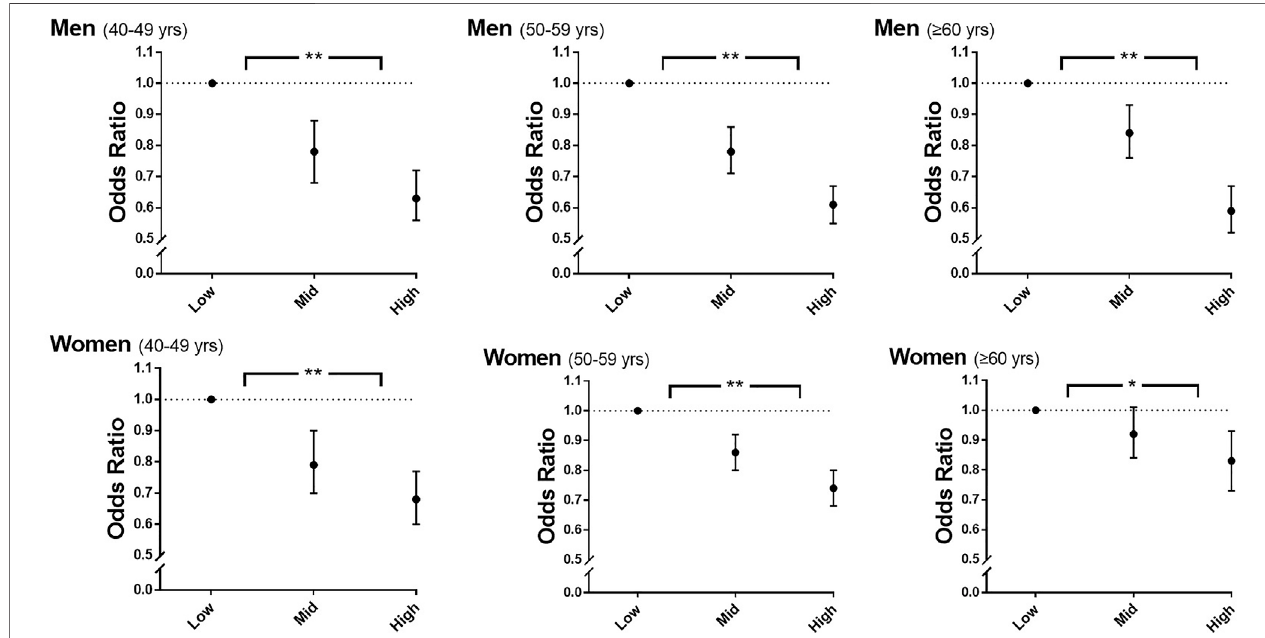
FIGURE2 | Odds ratios for hypertension according tosex-speci fi c tertiles ofrHGS and age. Adjusted for age, drinking, smoking, education level,total cholesterol, diabetes mellitus, visceral adiposity index, and PA-time. rHGS, relative handgrip strength; PA-time,. total time (min/week) expended for participating regularly in any sports or exercise to the point of sweating; yrs, years; *, p < 0.001 in the test for trend of ORs; **, p < 0.0001 in the test for trend of ORs.